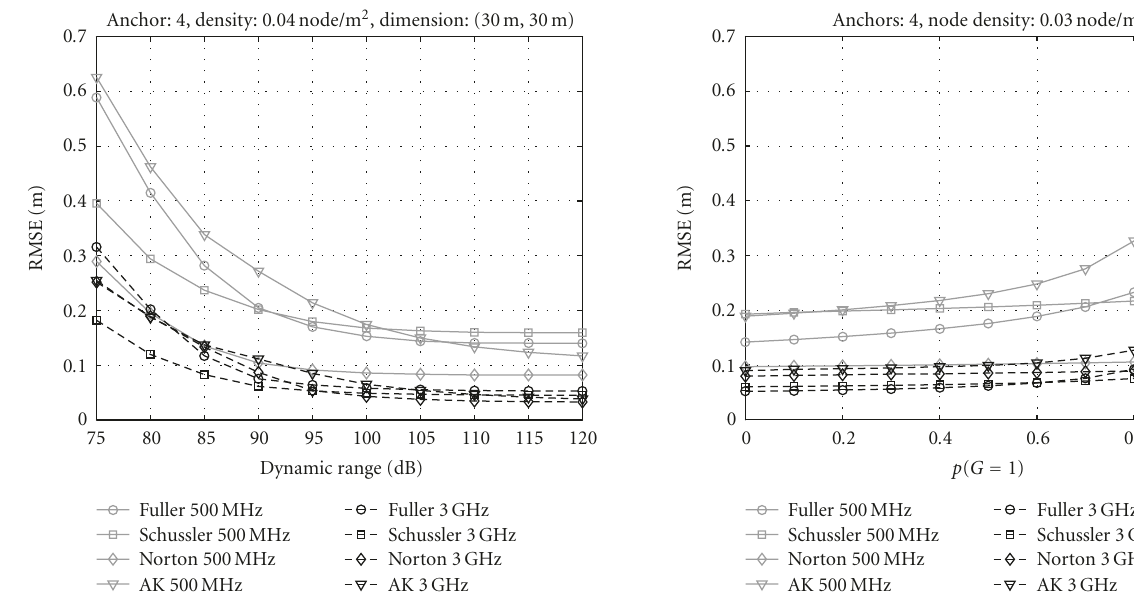
Figure 7: Localization performances as a function of dynamic range, ρ , for 500 MHz and 3GHz models.